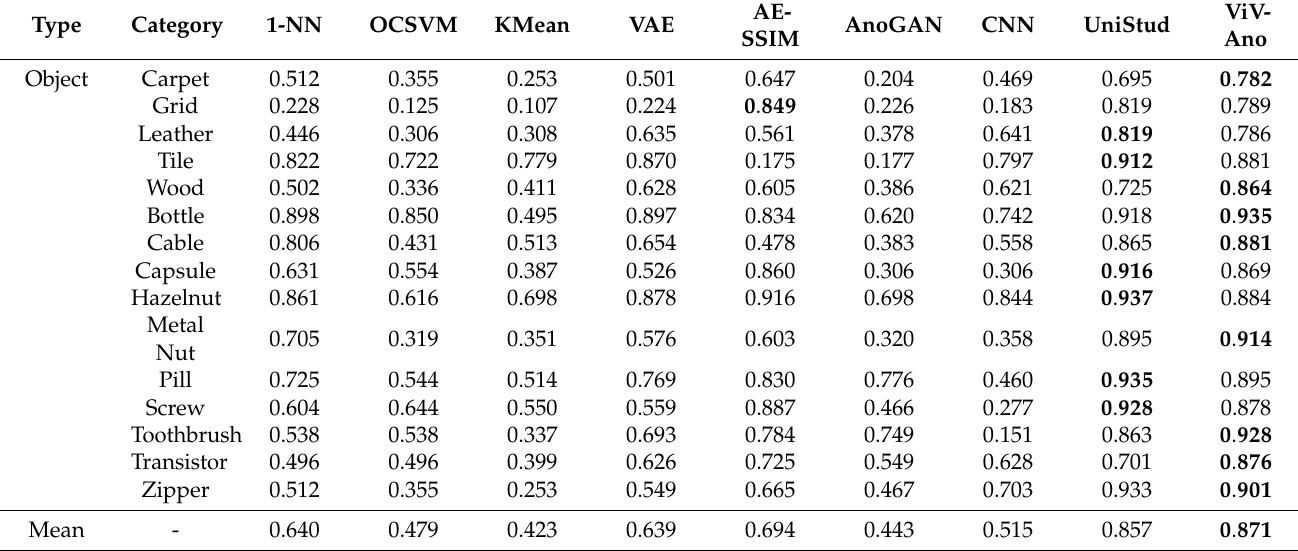
Table 3. Performance comparison of anomaly detection methods on